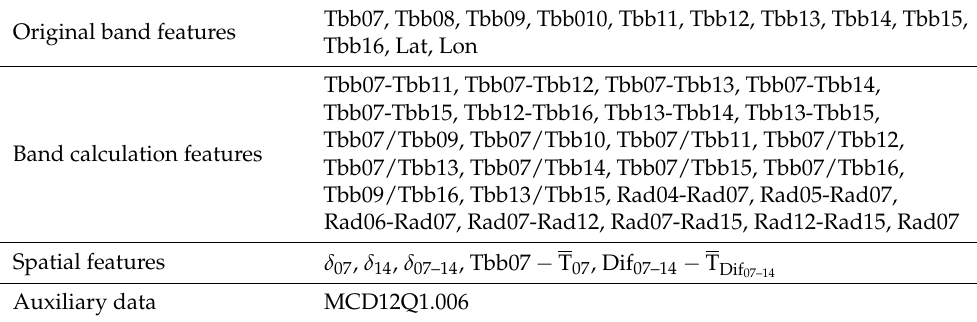
Table 2. Features used to construct the RF